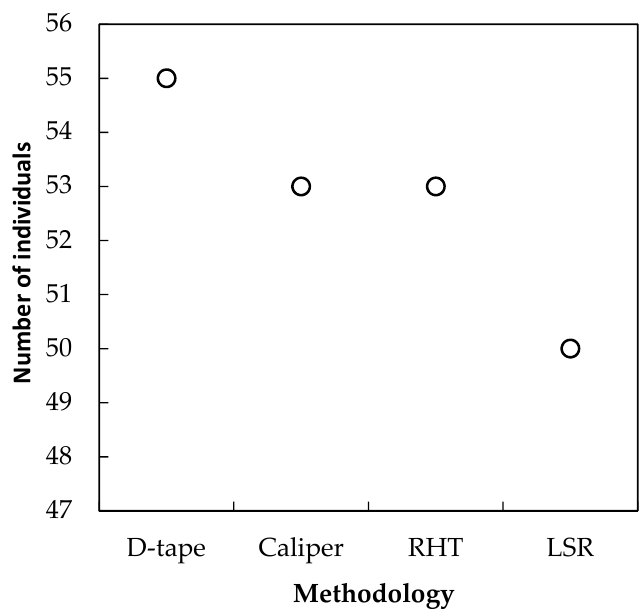
Figure A2. The number of individuals identified within the diameter inclusion limit (DBH ≥ 10 cm) for respective methodology applied, i.e., diameter tape (D-tape), electronic caliper (Caliper), terrestrial laser scanner circle fitted via Hough transformation (RHT), and least-squares method (LSR).